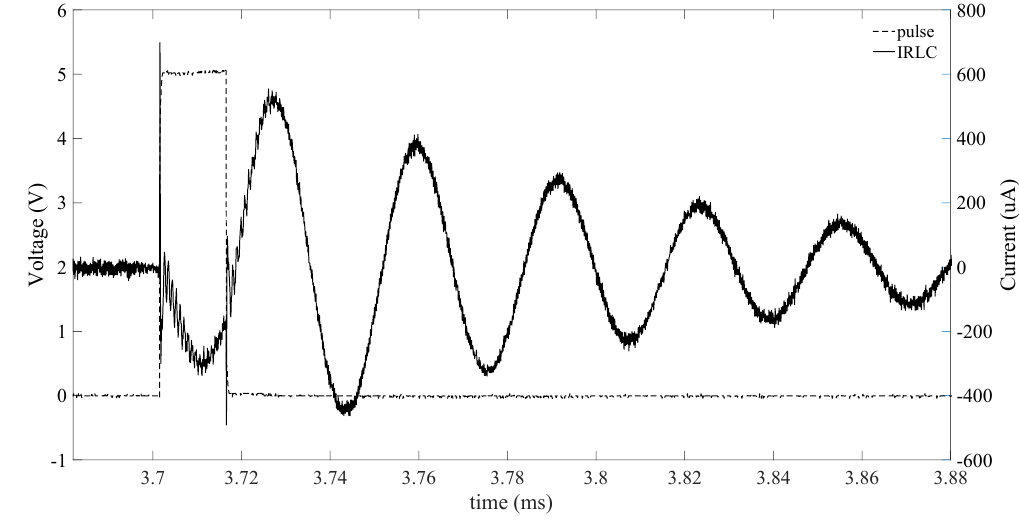
Figure 23. Best duty cycle for the input pulse.